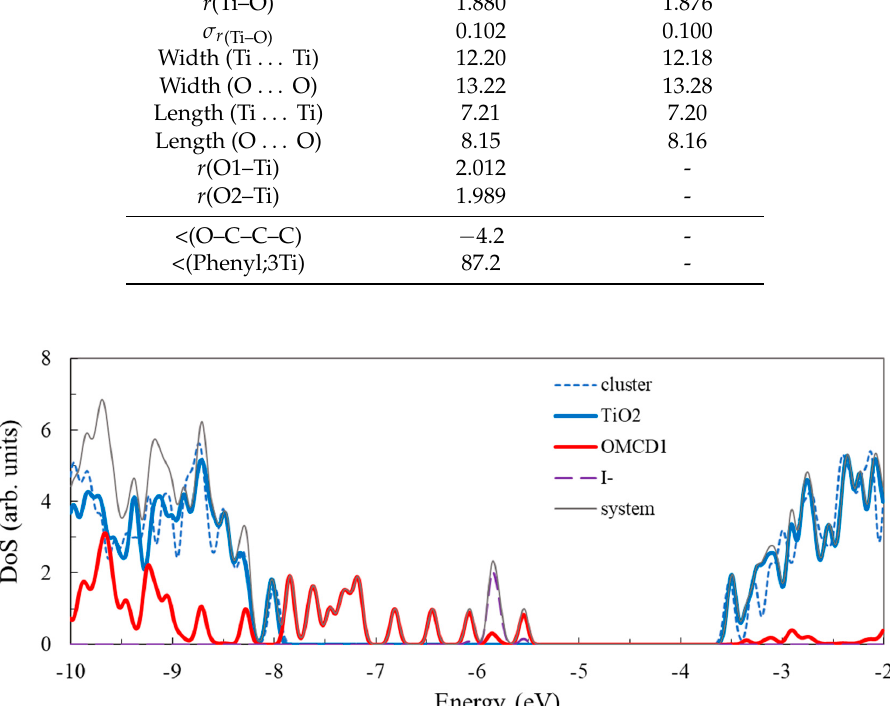
Table 6. The structural parameters of the model system consisting of the Ti 24 O 50 H 4 clusters with an adsorbed OMCD1 molecule, and of the bare cluster, obtained after geometry optimization by DFT/B3LYP/3-21G(d) in vacuum. Geometrical parameters describing the adsorption modes: bond lengths (in Å), the torsion angle of the carboxyl group relative to the indoline plane, and the dihedral angle defined by the indoline plane and the plane of the three neighbor Ti atoms on the cluster surface (both in deg). Parameter OMCD1 on Ti 24 O 50 H 4